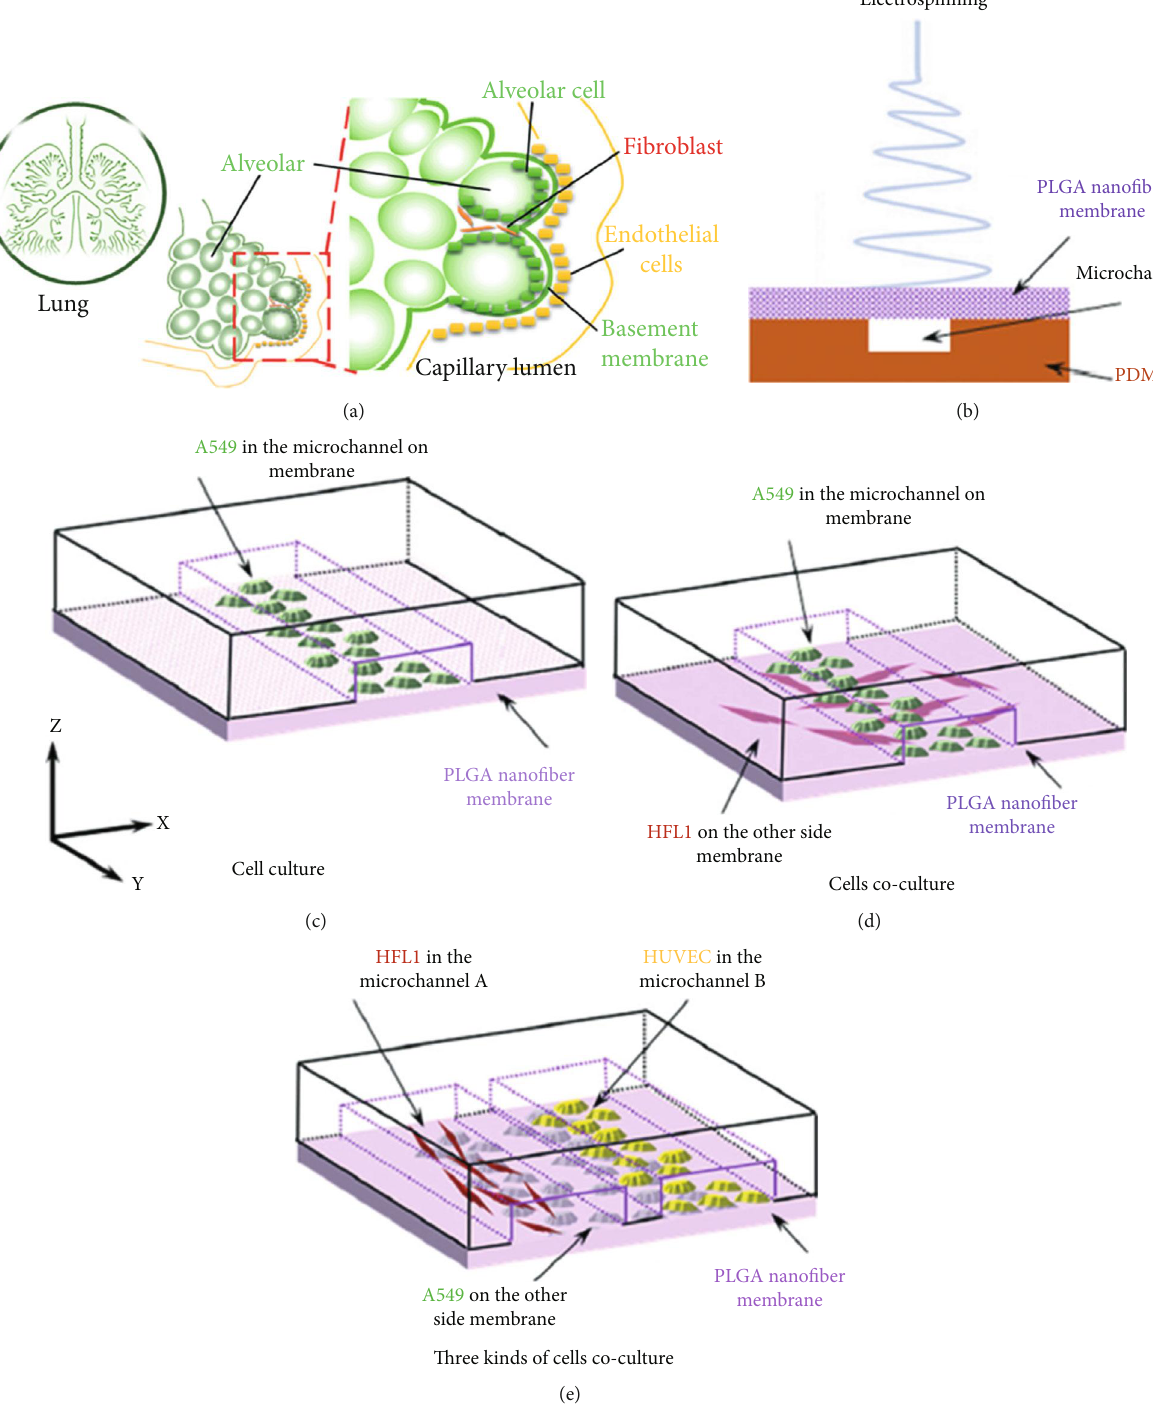
Figure 11: (a) Schematic diagram of the alveolar structure. (b) Schematic diagram of micro fl uidic chip with PLGA nano fi ber membrane as substrate prepared by electrospinning. (c) Schematic diagram of culture of A549 cells on the chip. (d) Schematic diagram of the coculture of A549 cells and HFL1 cells. (e) Schematic diagram of the coculture of A549 cells, HFL1 cells, and HUVECs. Reproduced (or adapted) with permission [73], ©2018, Royal Society of